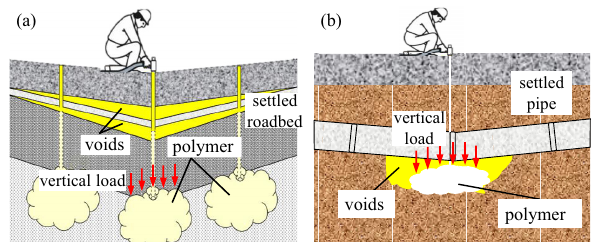
Figure 1: Representative applications of the TFPU grouting materials in civil engineering: ( a ) roadbed rehabilitation and ( b ) pipeline voids